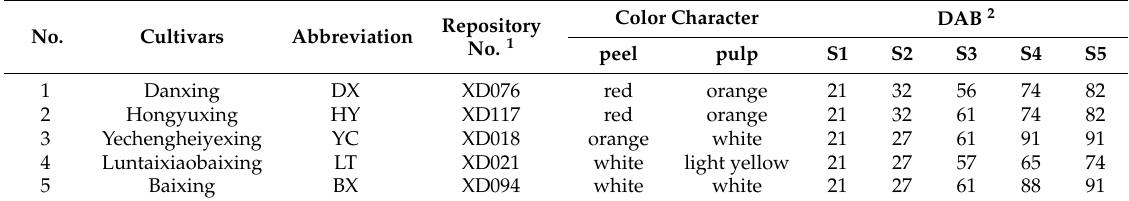
Table 1. Apricot cultivars used in the present study and the sampling time for each